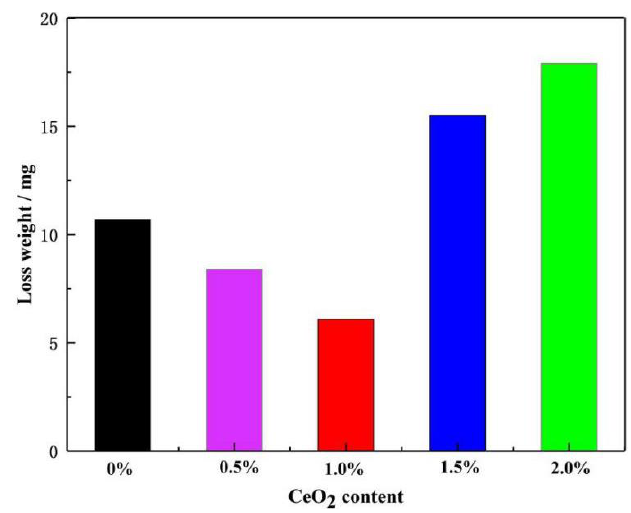
Figure 9. Wear loss weight changes in modified composite coatings containing different amounts of CeO 2 .